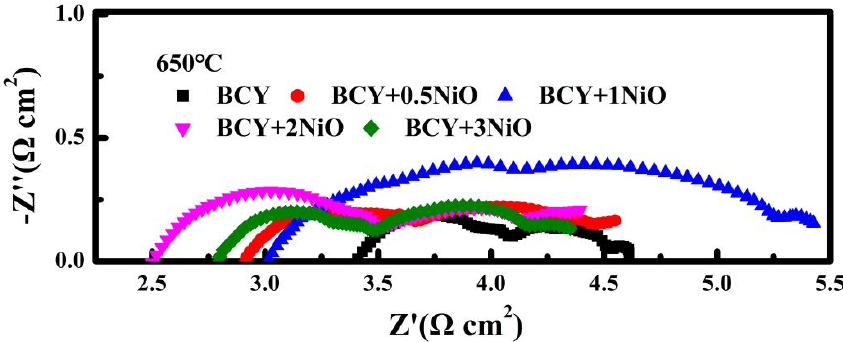
Figure 5. Impedance spectra of BCY–NiO ceramic electrolyte sheets measured in water-vapor atmosphere at 650 ◦ C.